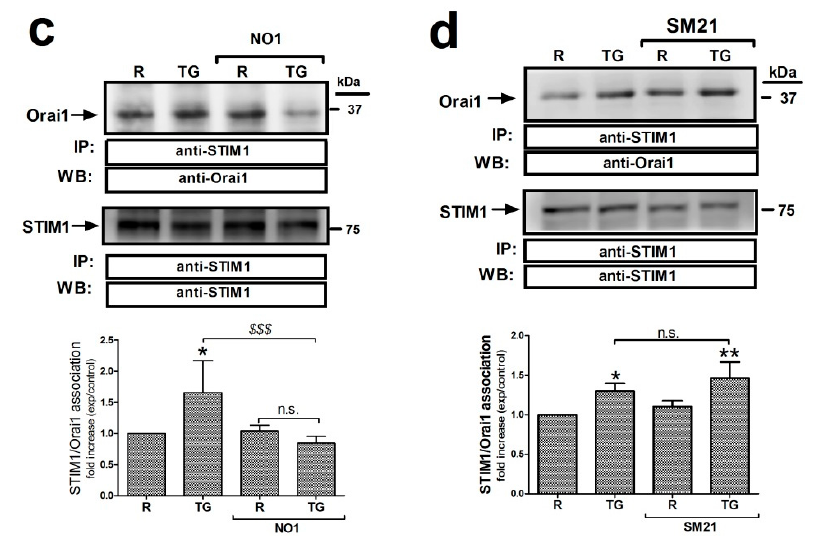
Figure 7. σ 2R/TMEM97 interacts with STIM1 but not with Orai1. ( a ) MDA-MB-231 cells suspended in Ca 2+ -free Hepes buffer saline (HBS) medium were left untreated or stimulated with thapsigargin (TG) (2 μ M) in the absence or presence of SM21 (100 nM). Next, they were fixed by mixing with an equal volume of NP40. Cell samples were immunoprecipitated using the specific anti-STIM1 antibody. On the following day, immunoprecipitated STIM1 complexes were suspended in PBS, and then incubated with 100 nM of NO1 for 5 min in order to evaluate the amount of σ 2R/TMEM97 pulled down with STIM1. NO1 fluorescence in each cell batch was analyzed using a TECAN plate reader (390 nm/505 nm of Ex/Em). It was represented as a fold increase of the values of NO1 fluorescence found in resting cells. * and ***: represent p < 0.05 and p < 0.001, respectively, compared to the resting cells; meanwhile, $$$ : represents p < 0.001 respect cells nontreated with the σ 2R/TMEM97 ligands. ( b ) Orai1 and σ 2R/TMEM97 interaction was analyzed using confocal microscopy. Untreated cells or cells stimulated with TG (2 μ M for 1 min) in a Ca 2+ -free HBS medium were then incubated for 5 min with NO1, and subsequently fixed by mixing with ice-cold paraformaldehyde. Then, cells were permeabilized (NP-40 buffer was used) and incubated with a bovine serum albumin (BSA) rich buffer (to avoid the antibodies’ unspecific binding sites). Finally, the samples were incubated with an anti-Orai1 antibody. Visualization of Orai1 was achieved by using a Cy™3 secondary fluorescent antibody following the protocol described in the Material and Methods. Fluorescent images of the cells were acquired using a confocal microscopy in order to analyze the colocalization. Bar represents 50 μ m. ( c ) MDA-MB-231 cells were suspended in Ca 2+ -free HBS medium (75 μ M EGTA was added) and incubated for 5 min with either the vehicle or NO1 (( c ); 100 nM for 5 min), or with SM21 (( d ); 100 nM for 5 min), after which they were left untreated (R: resting) or were incubated with TG (2 μ M, TG) for 1 min to stimulate store-operated calcium entry (SOCE), and then finally mixed with NP40 buffer. STIM1 was immunoprecipitated by incubating cell samples overnight with 2 μ g/mL anti-STIM1 antibody and beads of agarose. The following day, immunoprecipitated STIM1 complexes were denaturalized by mixing with LB, and subsequently, WB, using a specific anti-Orai1 antibody, as described in the Material and Methods section. Reprobing of the membranes with the anti-STIM1 antibody was done as loading control. Images are representative of 6–10 independent WB experiments. Histograms represent the mean ± standard error of the mean (S.E.M.) of the protein fold increase with respect the STIM1/Orai1 interaction found in resting cells. *, **: represent p < 0.05 and p < 0.001 respect to resting cells; $$$ represents p < 0.001 compared to cells nontreated with the σ 2R/TMEM97 ligands.